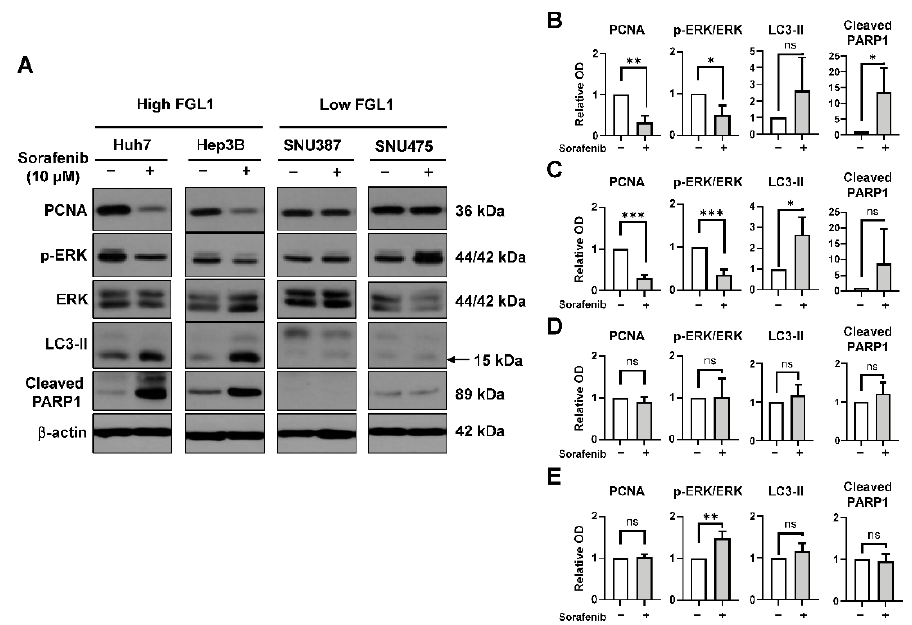
Figure 3. Effect of sorafenib on cell death and cell proliferation factors in high FGL1- and low FGL1-expressing hepatocellular carcinoma (HCC) cell lines. ( A ): Protein expression was analyzed by western blotting 48 h after treatment with 10 µ M sorafenib. Expression levels of PCNA, p-ERK/ERK, LC3-II, and cleaved PARP1 quantified in Huh7 ( B ), Hep3B ( C ), SNU387 ( D ), and SNU475 ( E ) cell lines. Data are presented as the mean ± standard deviation (SD) (n = 3). * p < 0.05, ** p < 0.01, and *** p < 0.001, significantly different from 0 μ M sorafenib-treated cells.